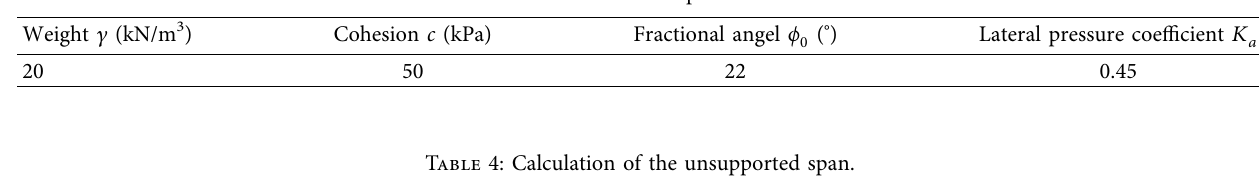
Figure 8: Model tests of the tunnel face and the unsupported span [19]. (a) The unsupported span is 2.0m. (b) The unsupported span is 3.0m. (c) The unsupported span is 4.5m. (d) The unsupported span is 5.0m. Table 3: Calculation parameters.